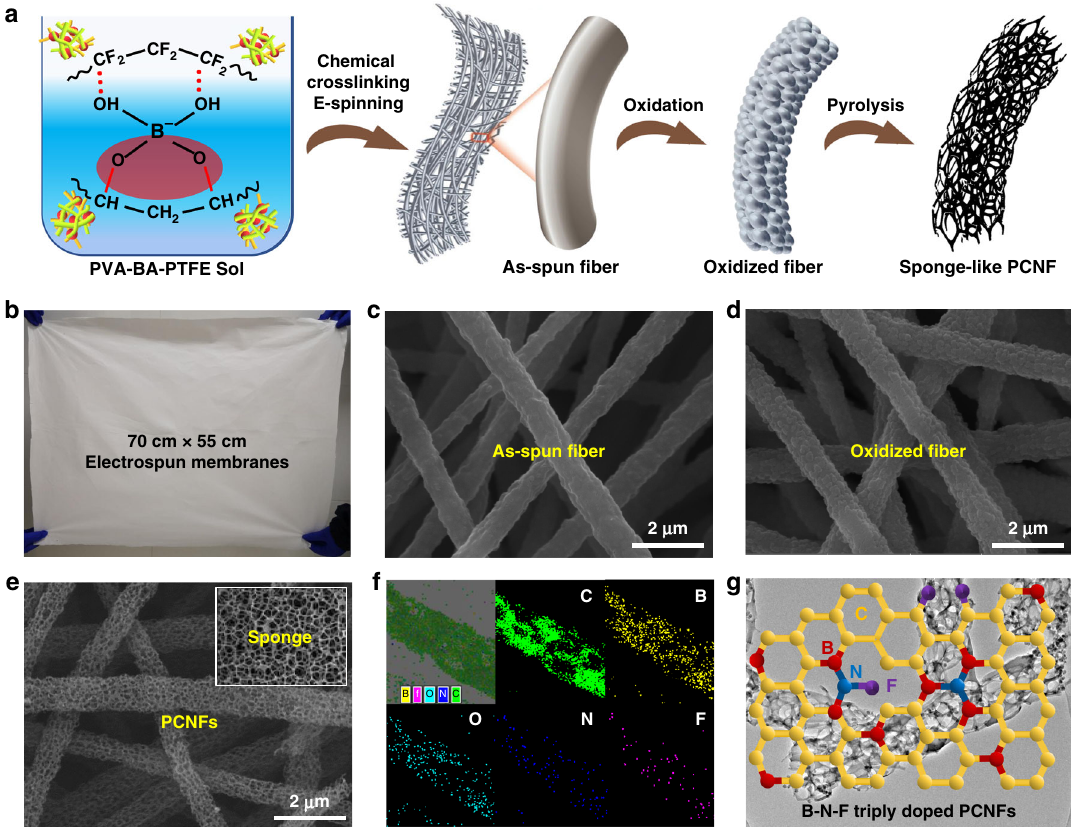
Fig. 1 Fabrication of B – N – F triply doped sponge-like PCNFs. a A general picture of using the chemical crosslinking electrospinning method to synthesize PCNFs. b A digital photo of the as-spun fi lm with a size of 70 cm× 55 cm. c – e Scanning electronic microscopy (SEM) images of the as-spun fi bers, the oxidized fi bers and the PCNFs. f EDS mapping spectrum of PCNFs. g The proposed chemical model of B-N-F doped